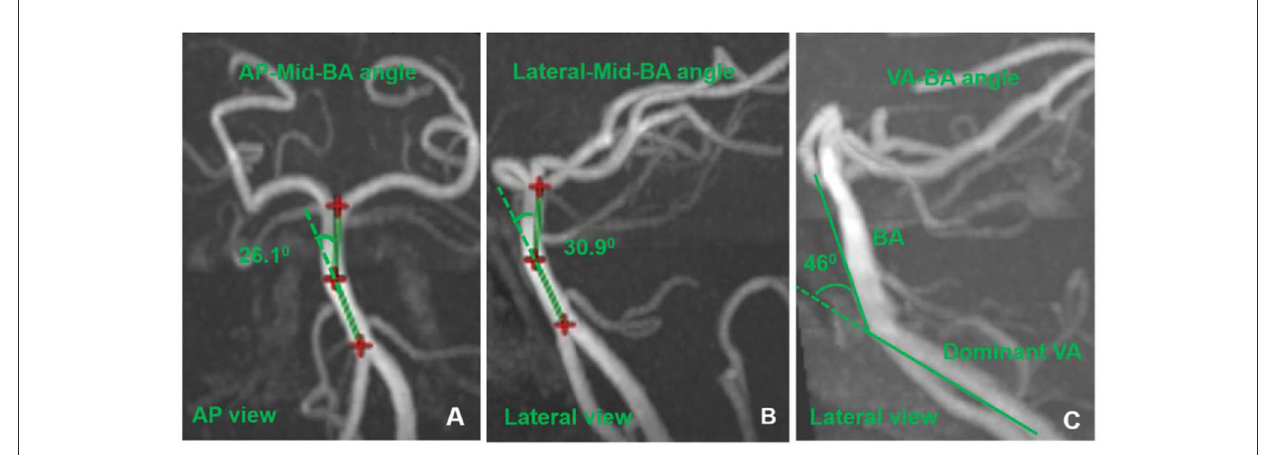
FIGURE3 The measurement of AP-mid-BA angle (A) , lateral-mid-BA angle (B) , and VA-BA angle (C) . BA, basilar artery; VA, vertebral